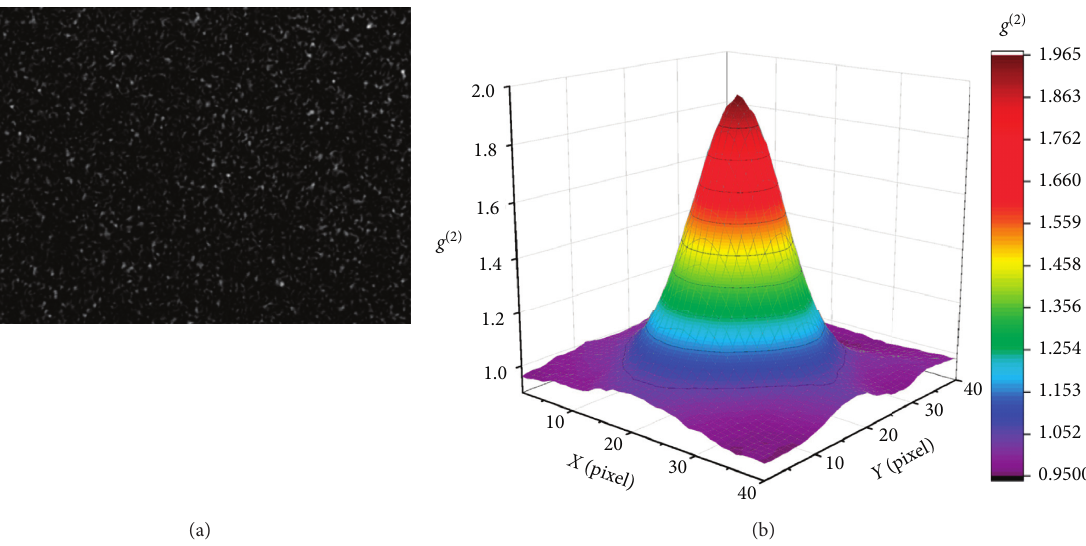
Figure 8: The measured g ( 2 ) value of the passively Q -switched laser generating pseudothermal light: (a) the image achieved by CCD; (b) the corresponding pseudo-colour map of the second-order correlation